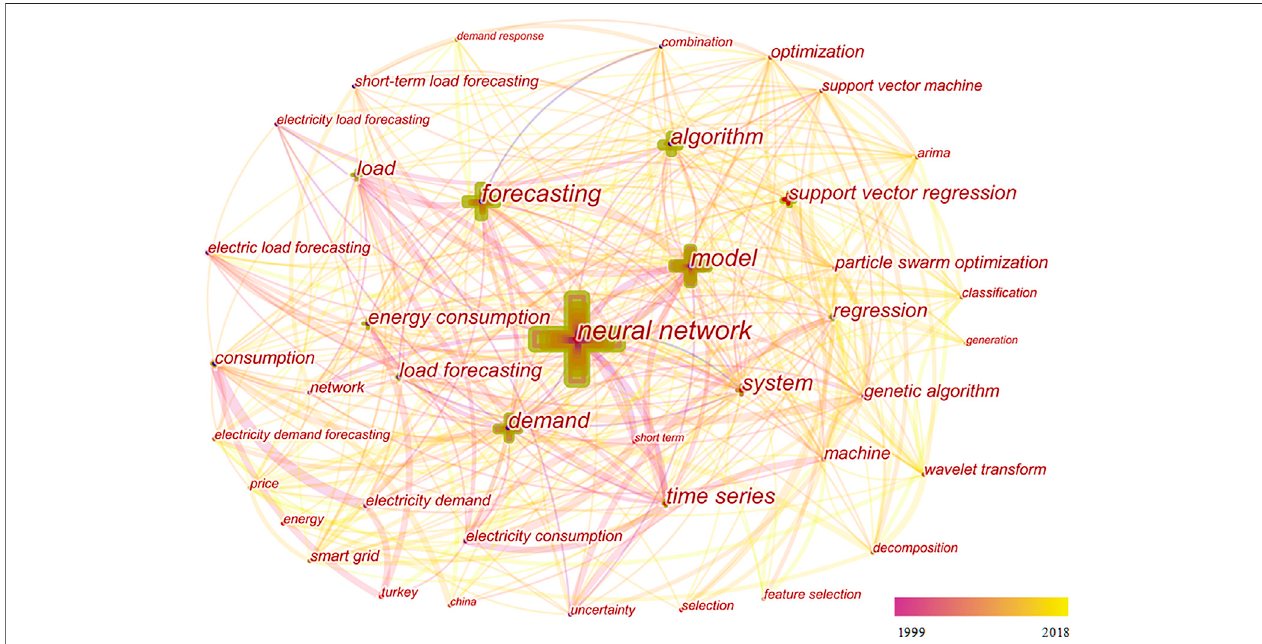
FIGURE 9 | Keyword co-occurrence network in electricity demand